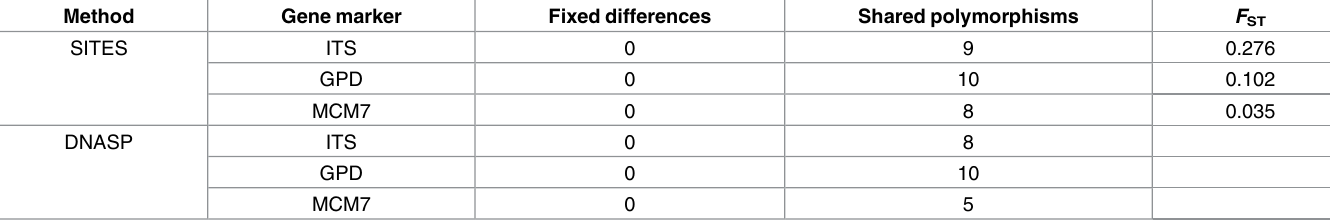
Table 2. Analysis of DNA polymorphisms and Fst values for a comparison of H . flavida and H . hypotrypa .